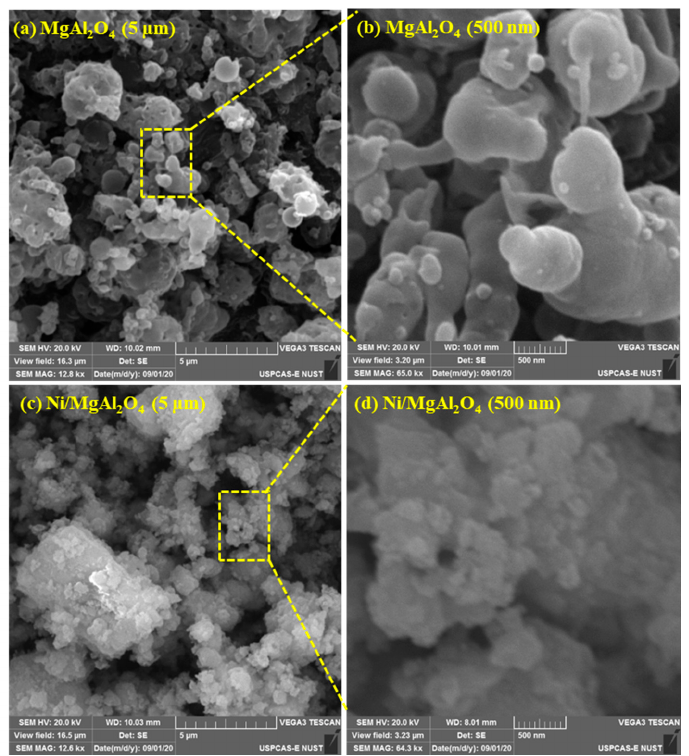
Figure 4. SEM micrograph of synthesised fresh samples; ( a , b ) MgAl 2 O 4 ( c , d ) 10 wt%Ni / MgAl 2 O 4 having 5 µ m and 500 nm of magnification.